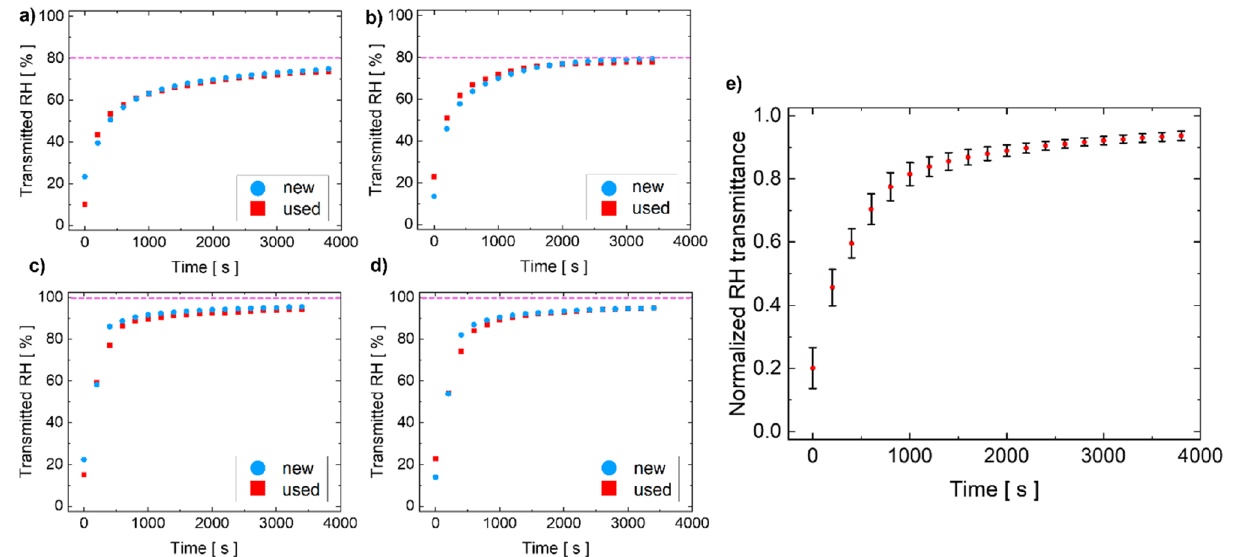
Figure 2. Time evolution of relative humidity transmitted through a new and 24-h used face mask in two experiments: gas source set to 80% RH diluted in synthetic air (pink dotted line) outwards ( a ) and inwards ( b ); gas source set to 100% RH diluted in pure nitrogen (pink dotted line) outwards ( c ) and inwards ( d ); mean values and standard errors of the eight normalized transmittances ( e